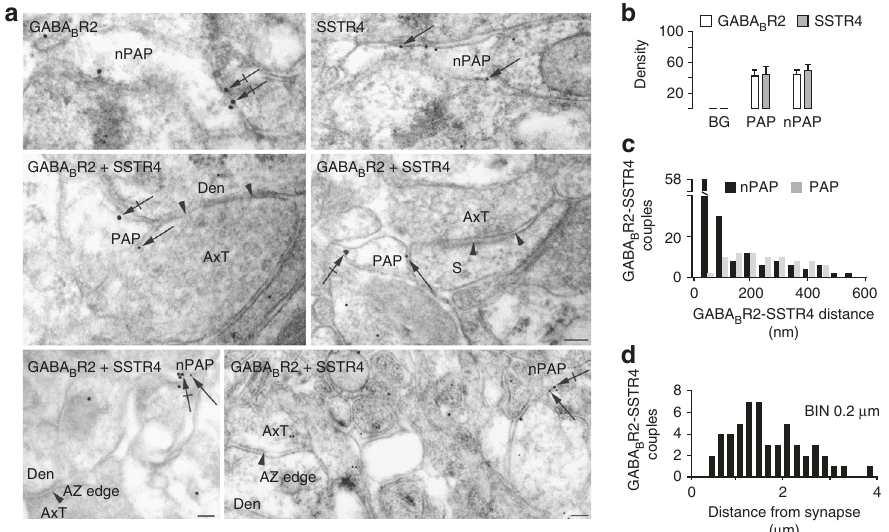
Fig. 5 GABA B Rs and SST4Rs colocalize at non perisynaptic astrocytic processes (nPAPs). a Upper row, GABA B2 and SSTR4 immunogold EM single-labeled nPAPs (arrows point to 18 and 12 nm membrane-associated gold particles, respectively). Middle row, GABA B2 -SSTR4 double-labeled PAPs nearby to an axo-dendritic shaft (left) and an axo-spinous (right) symmetric synapse (arrowheads point to edges of active zones). Lower row, double-labeled nPAPs not in the proximity of symmetric synapses (arrowheads). b GABA B2 and SSTR4 relative density (particles/ μ m 2 ) in double-labeled PAPs ( n = 40) and nPAPs ( n = 77) is higher than background (BG; p < 0.0001, Mann – Whitney test), whereas it is similar between PAPs and nPAPs. c Distance distribution of immunogold GABA B2 and SSTR4 pairs at PAP membranes (40 pairs from 37 PAPs) and nPAPs (100 pairs from 97 nPAPs). d Lateral position of GABA B2 and SSTR4 pairs with an edge-to-edge distance within 50 nm with respect to the closest AZ margin of a symmetric synapse (53 couples from 53 nPAPs). Axt, axon terminal; Den, dendrite; s, spine. Scale bars, 100